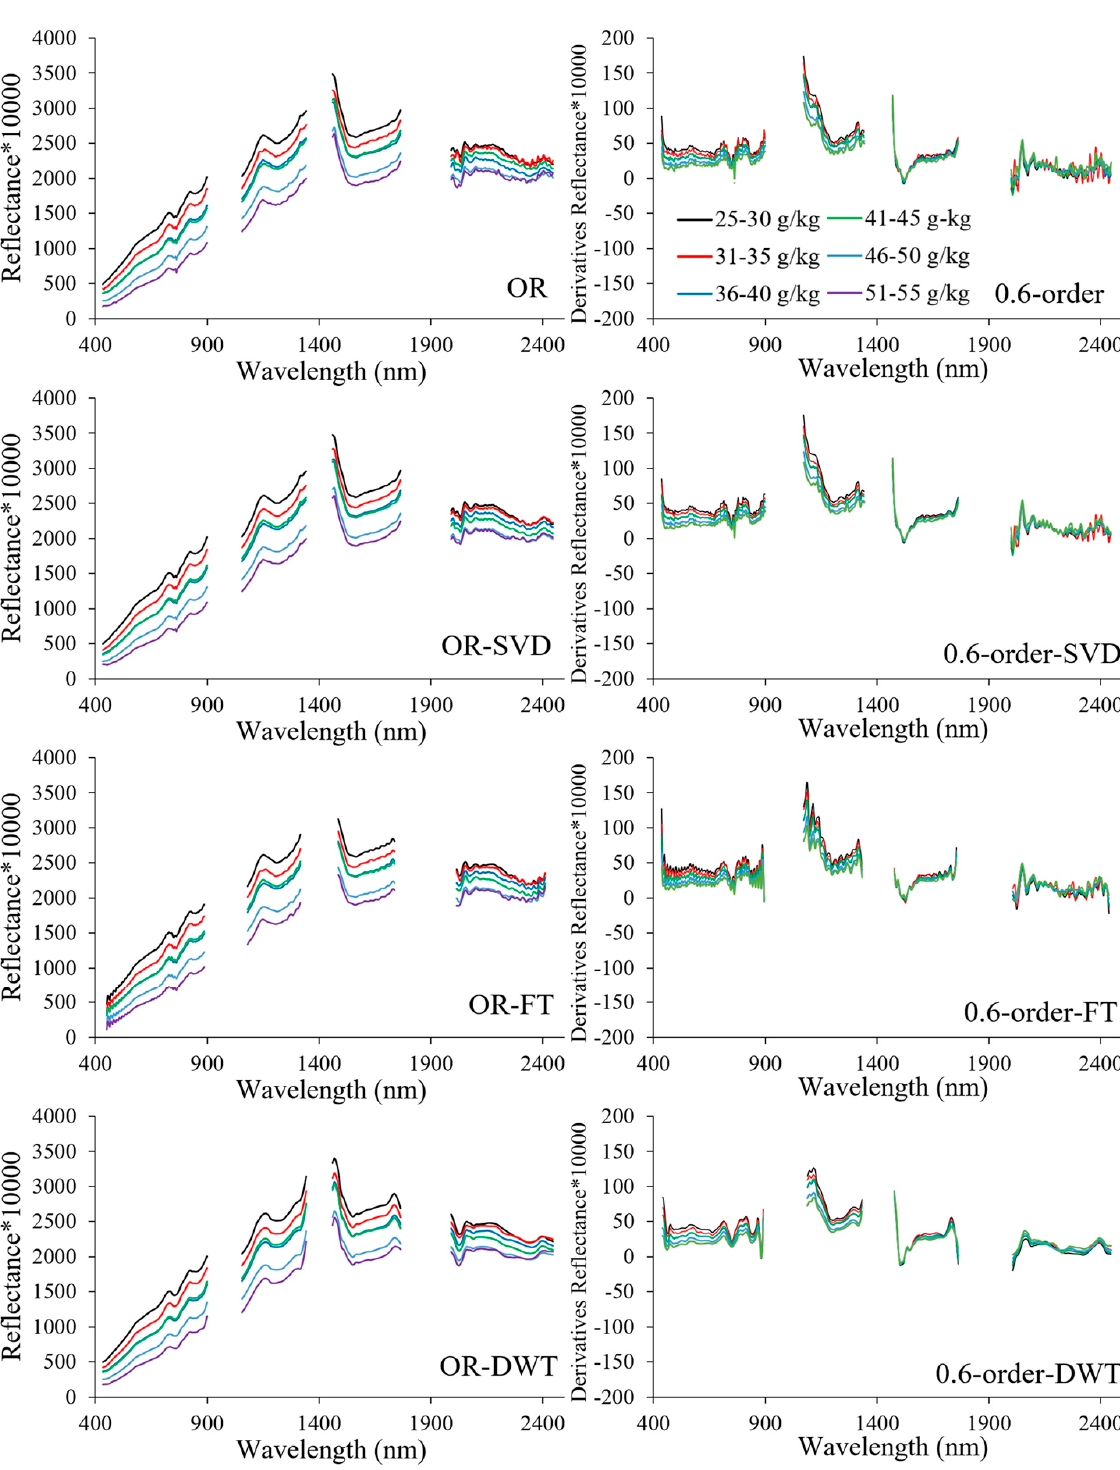
Figure 3. Spectral reflectance curves under different denoising methods. Note: OR represents the original reflectance. OR-SVD, OR-FT, OR-DWT and 0.6-order represents the reflectance after singular value decomposition, fourier transform, discrete wavelet transform and 0.6-order derivatives processing, respectively. 0.6-order-SVD, 0.6-order-FT and 0.6-order- DWT represents the 0.6-order reflectance after singular value decomposition, fourier transform and discrete wavelet transform processing,